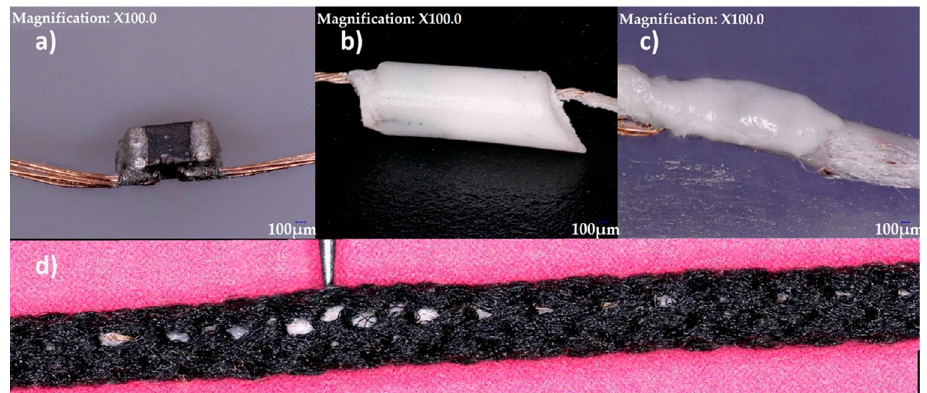
Figure 1. Photographs of prototype ETS yarn manufacturing process. ( a ) An eight-strand braided copper wire was soldered onto the thermistor; ( b ) The thermistor and copper wire were